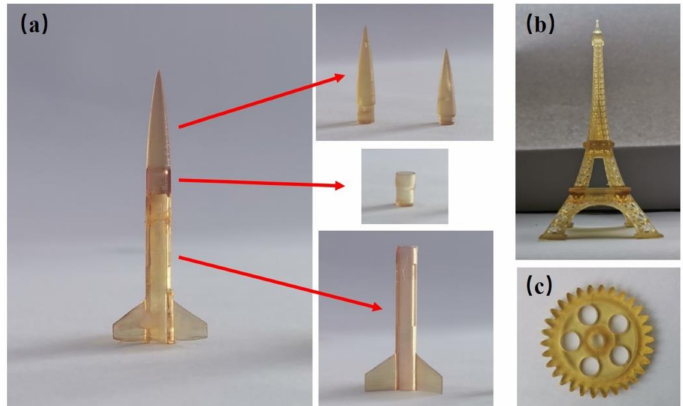
Figure 9. ( a ) Rocket-, ( b ) tower-, and ( c ) gear-like objects printed with BDM-5 ink by an SLA 3D